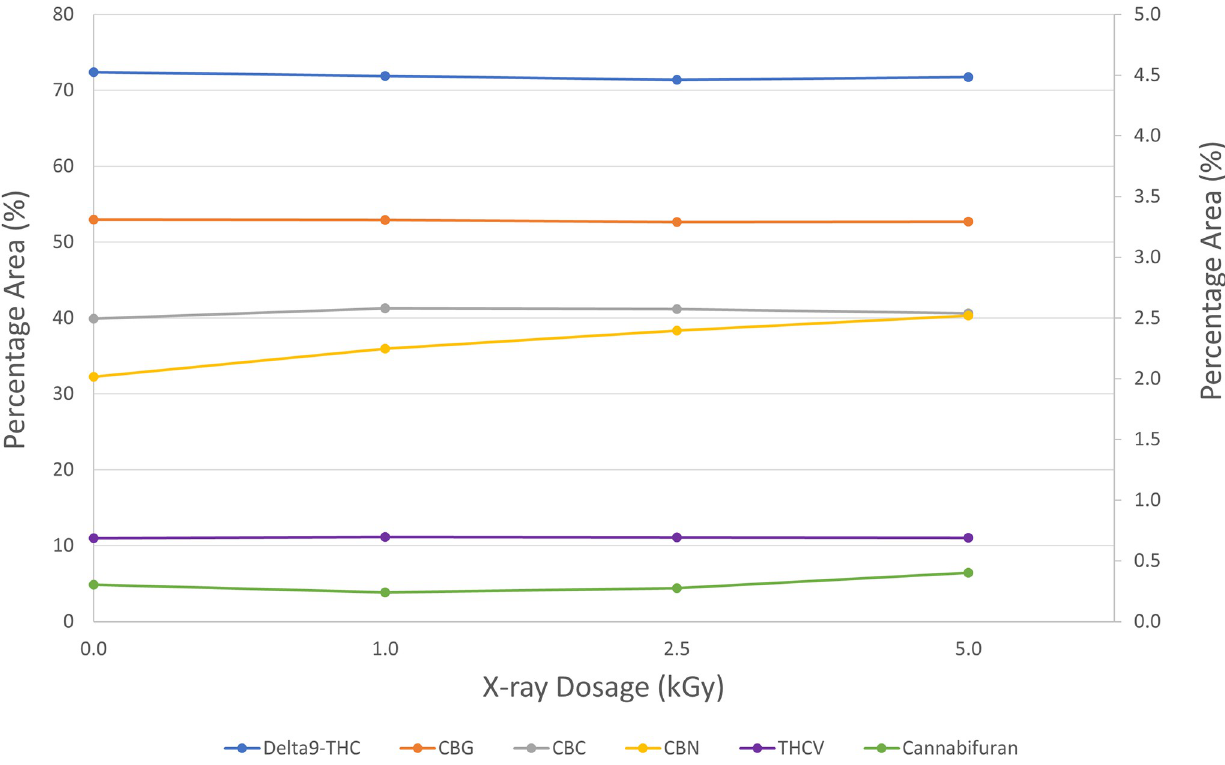
Fig 2. Qualitative cannabinoids profile changes in flower samples of untreated and treated at different X-ray irradiation dosage levels. Primary axis for delta9-THC, secondary axis for CBG, CBC, CBN, THCV, and cannabifuran. % Peak Area = area percentage of each peak or compound found in instrument analysis. It only roughly represents composition and amounts present in the